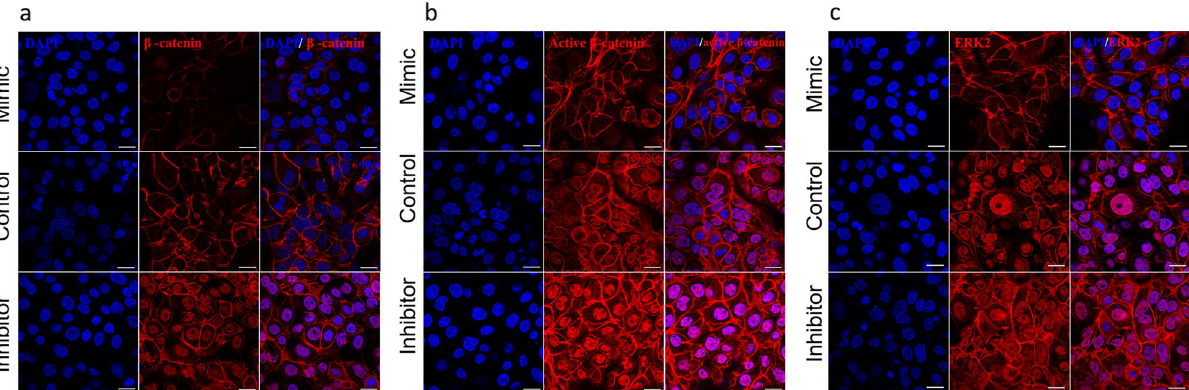
Figure 6. Localization of β-catenin, active β-catenin and ERK2 expression in hsa-miR-143-3p transfected cells in 3D RAFT. Representative confocal images of transfected primary limbal epithelial cells grown on 3D RAFT TEs immunostained for ( a ) β-catenin, ( b ) active- β-catenin and ( c ) ERK2. The nuclei were stained with DAPI (blue) and protein expression with Alexa Fluor 555 (red). Compared to the control and mimic transfected cells, the expression of β-catenin, active-β-catenin and ERK2 were higher in inhibitor transfected cells along with strong nuclear translocation. The relative protein expression values based on fluorescent intensity are provided in Fig. S5. Scale bar 50 µm. Nuclear localization of active-β-catenin and ERK2 indicates the activation of Wnt-β- catenin and MAPK signaling respectively. Target